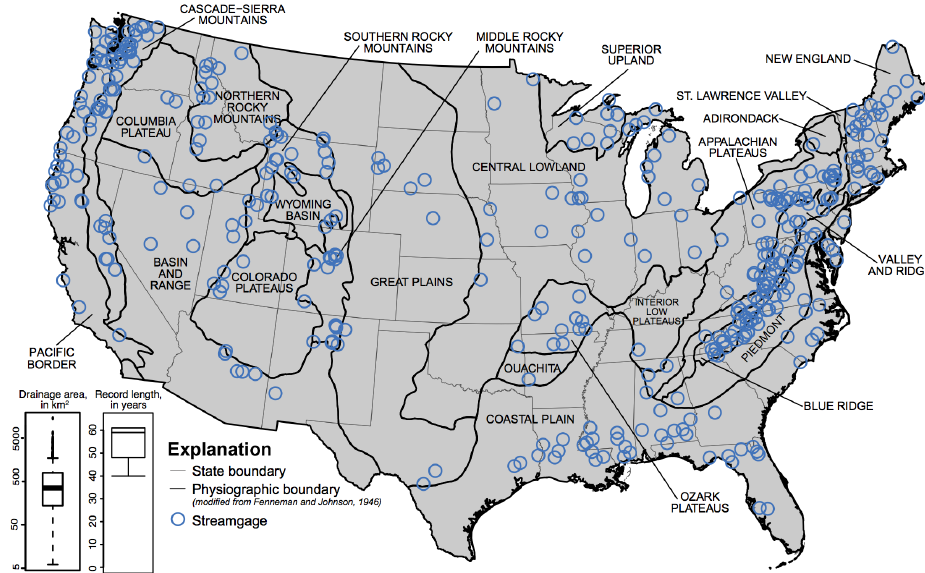
Figure 1. Map of the conterminous United States showing physiographic regions and the streamgages included in the study. Boxplots on the lower left show the range of drainage areas and record lengths represented by study